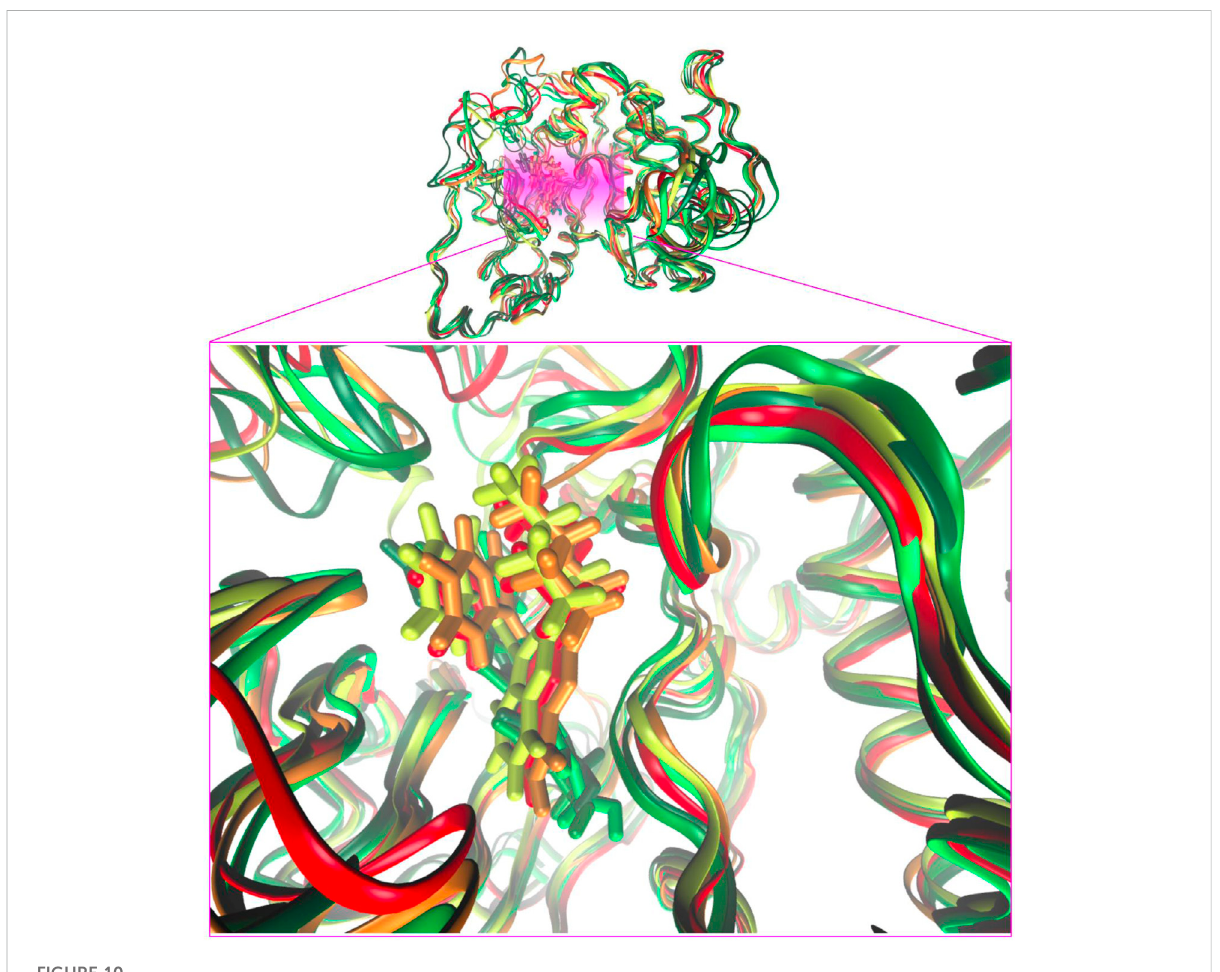
FIGURE 10 Superimposition of representative snapshots of the most populated clusters of the PKC- α /NVP trajectory (red-orange tones) and the corresponding ones that form the PKC- α /compound 3 (lime-green tones). Cluster analyses from the last 20 – 100